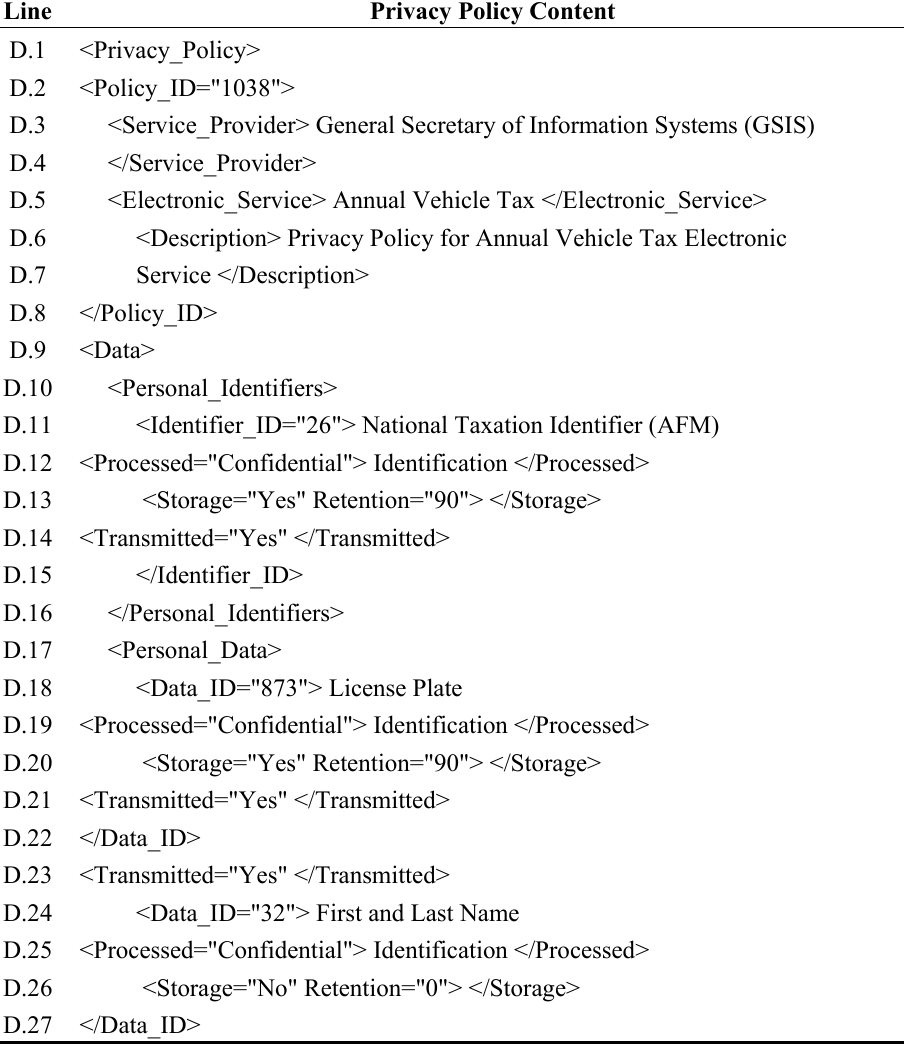
Table 6. AVT Service Non-Hierarchical Privacy